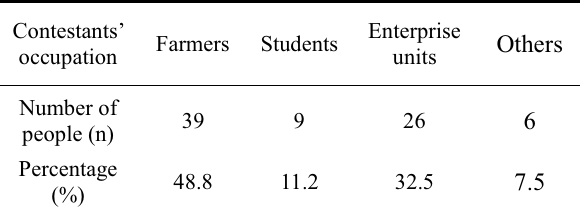
Table 2 Contestants in the "dragon boat race" of Ankang folk